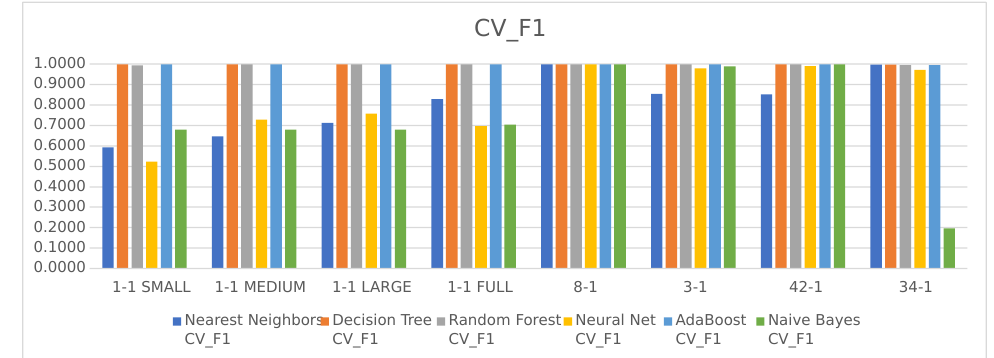
Figure 11. F1 score of techniques per dataset.